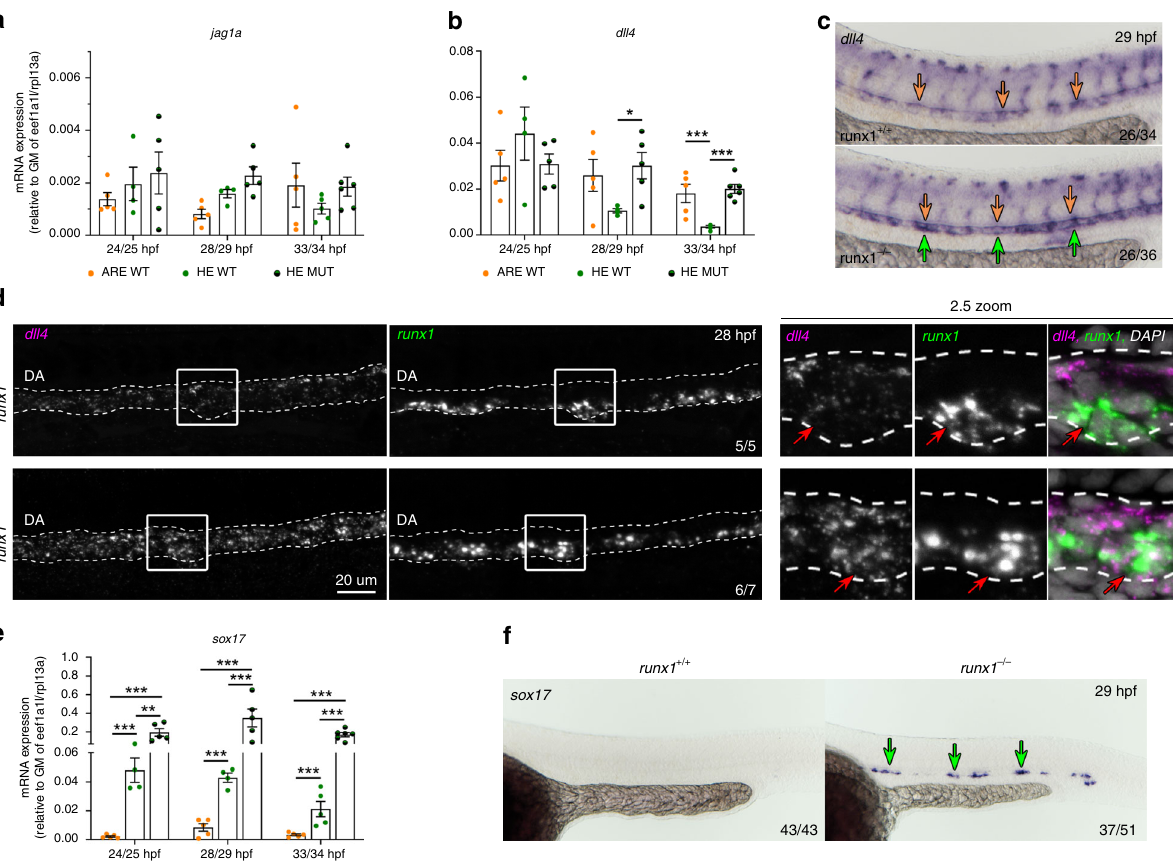
Fig. 5 Expression of dll4 in aortic HE is repressed by Runx1. a , b qRT-PCR gene expression analysis of NOTCH ligands jag1a and dll4 in the HE and ARE of runx1 + / + (WT) and the HE of runx1 − / − mutant (MUT) embryos. Graphs in ( a ), ( b ) and ( e ) show the mean of detected expression levels relative to the geometric mean (GM) of the two housekeeping genes eef1a1l and rpl13a . n = 5 independent biological experiments for WT embryos and n = 6 independent biological experiments for MUT embryos. Error bars represent the SEM. two-way ANOVA; * p < 0.05; ** p < 0.01; *** p < 0.001. c Spatial analysis of gene expression of dll4 in runx1 + / + and runx1 − / − embryos by ISH. Green arrows point to the HE. Orange arrows point to the DA roof. d Maximum intensity projection of representative confocal images of runx1 + / + and runx1 − / − embryos with double FISH for dll4 and runx1 . Red arrows in the close-up highlight the region of a runx1 + cell. e qRT-PCR gene expression analysis of sox17 in the HE and ARE of runx1 + / + (WT) and the HE of runx1 − / − mutant (MUT) embryos. f ISH analysis of sox17 in runx1 + / + and runx1 − / − embryos. Green arrows point to the